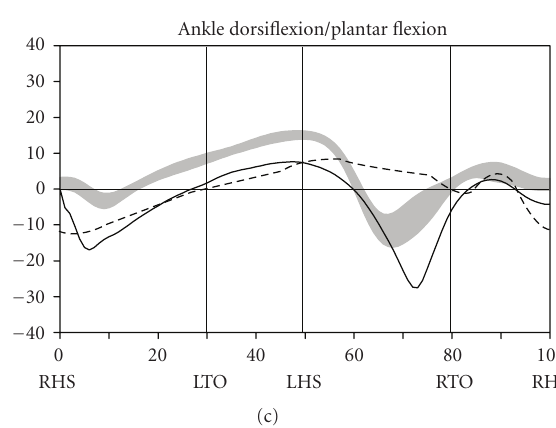
Figure 2: Normalized sagittal kinematics for the right hip, knee, and ankle joints for the pre- (dashed line) and post-SAVT (solid line) trials. Age-matched normal data (mean ± 1 SD) are represented by the gray band. The x -axis is normalized stride cycle, with right heel strike (RHS) occurring at 0% of the cycle, followed by left toe-o ff (LTO), left heel strike (LHS), right toe-o ff (RTO), and RHS. The y -axes are the joint angles (degrees) with the zero line representing neutral joint position. The same findings were noted on the left